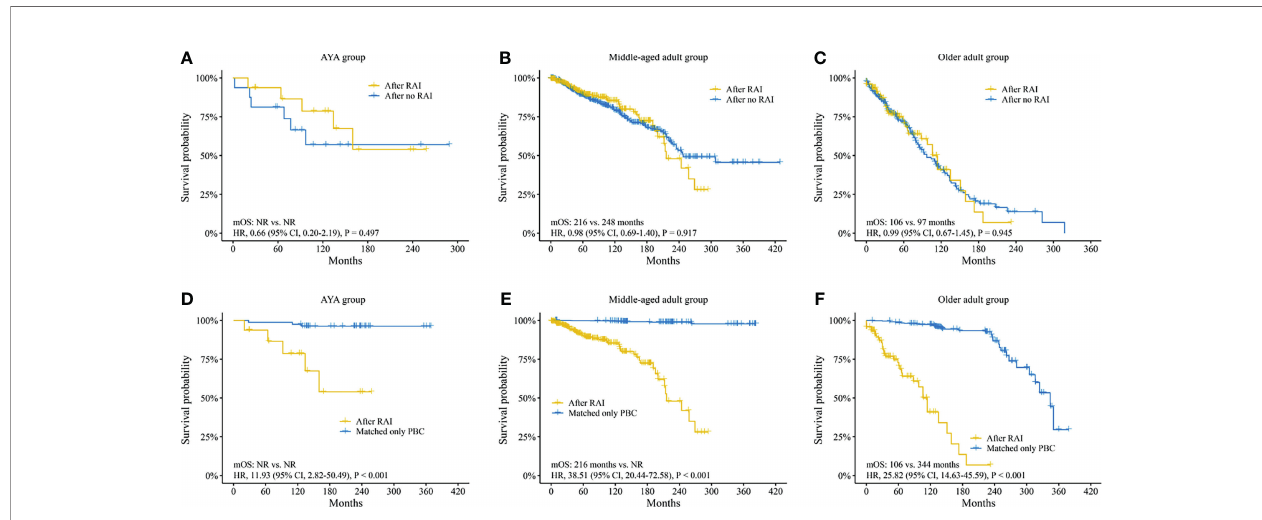
FIGURE 4 | Survival analysis of second breast cancer. Survival analyses between SBC patients after radioiodine and after no radioiodine in (A) AYA group, (B) middle-aged adult group, (C) older adult group. Survival analyses between SBC patients after radioiodine and patients with matched only primary breast cancer in (D) AYA group, (E) middle-aged adult group, and (F) older adult group. SBC, second breast cancer; AYA, adolescent and young adult; RAI, radioiodine; OS, overall survival; NR, not reached; HR, hazard ratio; CI, con fi dence interval; PBC, primary breast